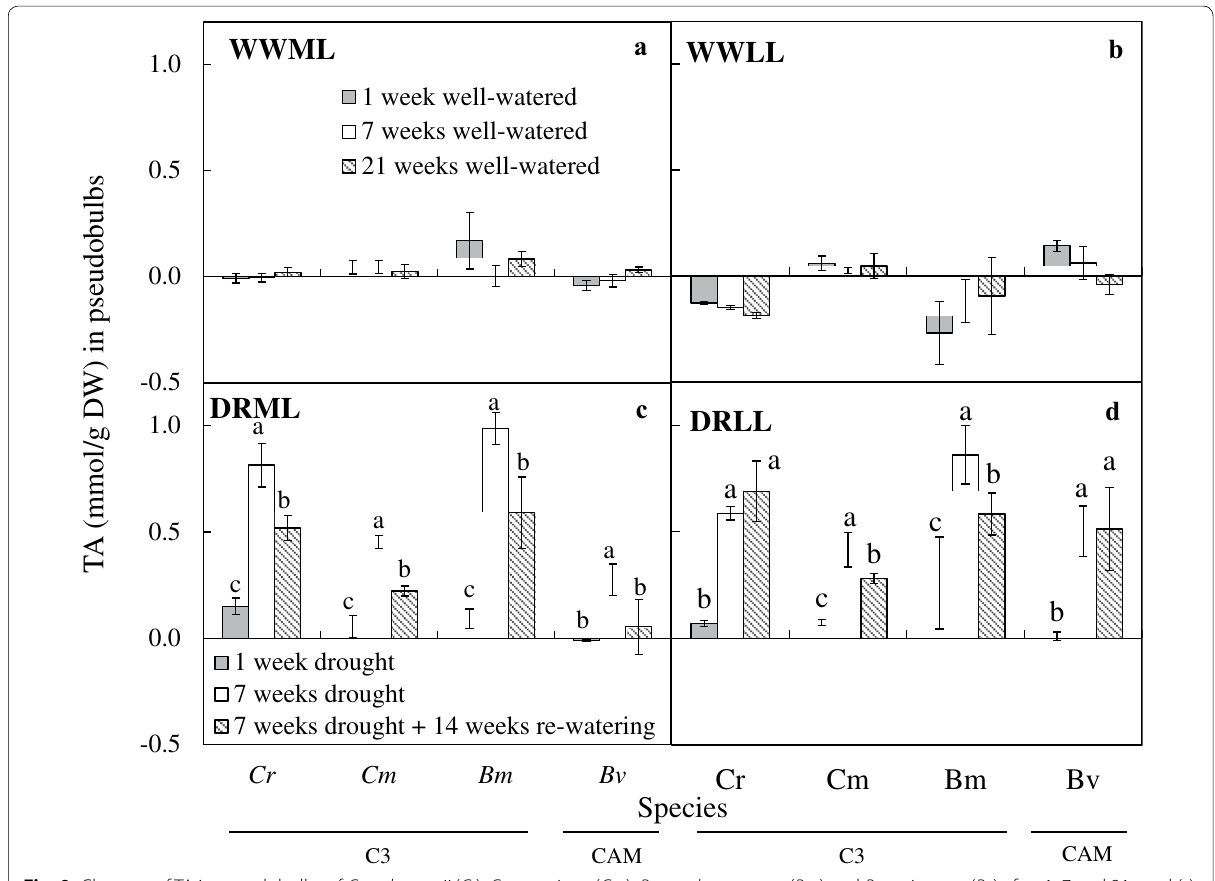
Fig. 9 Changes of TA in pseudobulbs of C. rochussenii ( Cr ), C. mayeriana ( Cm ), B. membranaceum ( Bm ) and B. vaginatum ( Bv ) after 1, 7 and 21 week(s) of well-watered condition under WWML ( a ), WWLL ( b ), and after 1 and 7 weeks of drought and after 14 weeks of re-watering under moderate light ( c ) and low light ( d ). Vertical error bars represent standard error. Different letters above bars indicate statistical difference (Tukey’s multiple comparison, p < 0.05, n =